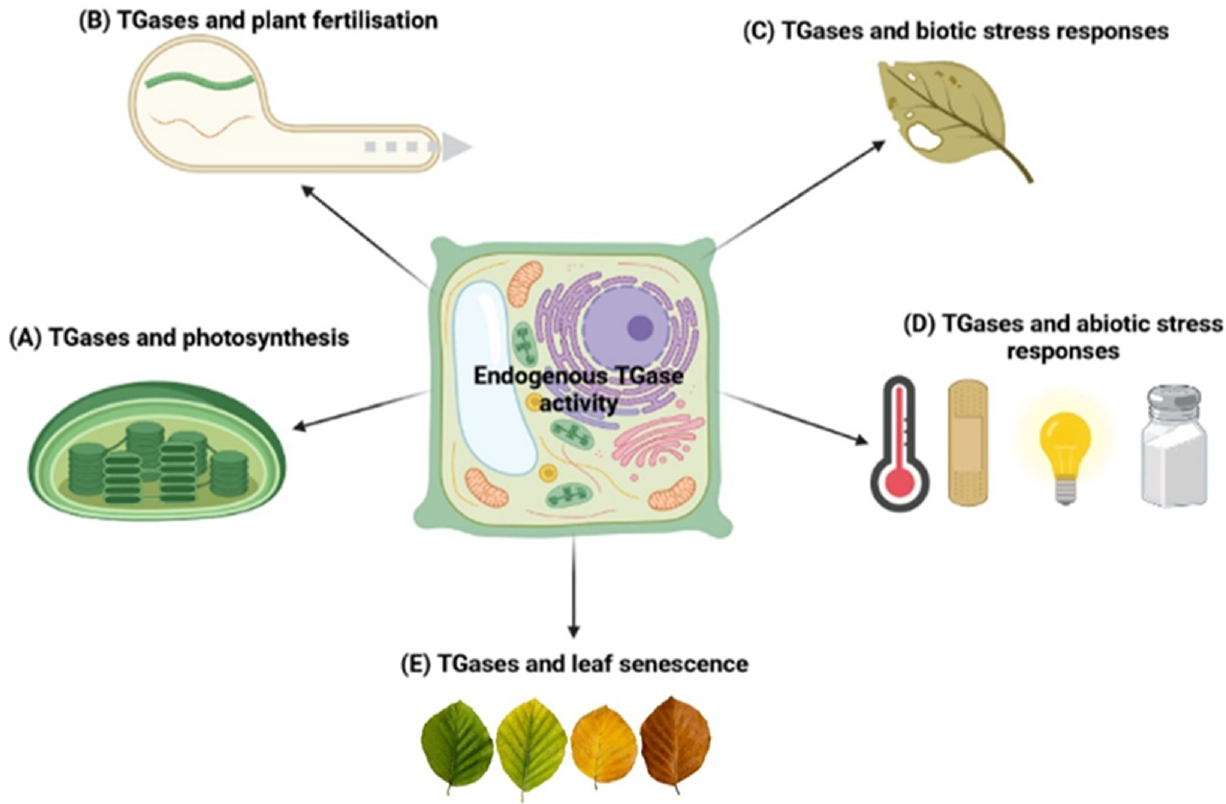
Figure 3. A model summarizing the main physiological roles of plant TGase. TGases have been found in several cellular compartments of different plants. In chloroplasts, TGases contribute to photosynthetic efficiency by increasing the level of bound PAs, ROS scavenging, and CO 2 assimi- lation. These aspects are related to the action of TGases on different substrates, e.g., RuBisCO PSII proteins, ATPase, and PMF proteins ( A ). The enzyme is also present in the cytosol, where it can post-translationally modify the cytoskeletal proteins directly or do so via the binding of PAs, con- tributing to its organisation. This happens in the elongation of the pollen tube ( B ). In plant–pathogen interactions, TGases behave similarly to a PAMP, e.g., the PEP-13 motif of Phytophthora infestans . Otherwise, specific plant TGase isoforms might contribute to plant defence mechanisms ( C ). Different abiotic stresses (temperature, wounding, light, and salt stress) stimulate TGase activity, improving plant resilience through the activation of several signalling pathways and the stimulation of several physiological processes, e.g., photosynthetic efficiency, HSP response, antioxidant system, and PA- based cell signalling. By specific inhibitor, TGase inhibition reduces resistance to abiotic stresses and causes decreases in the bound PA contents, decreases in the photochemical efficiency of PSII, and growth reduction ( D ). In the leaf senescence process, TGases increase the accumulation of HSPs and bound PAs. TGases are also involved in the modification of chloroplast proteins and the modulation of anti-senescence enzymes and ATP synthases, finally increasing the photosynthetic efficiency ( E